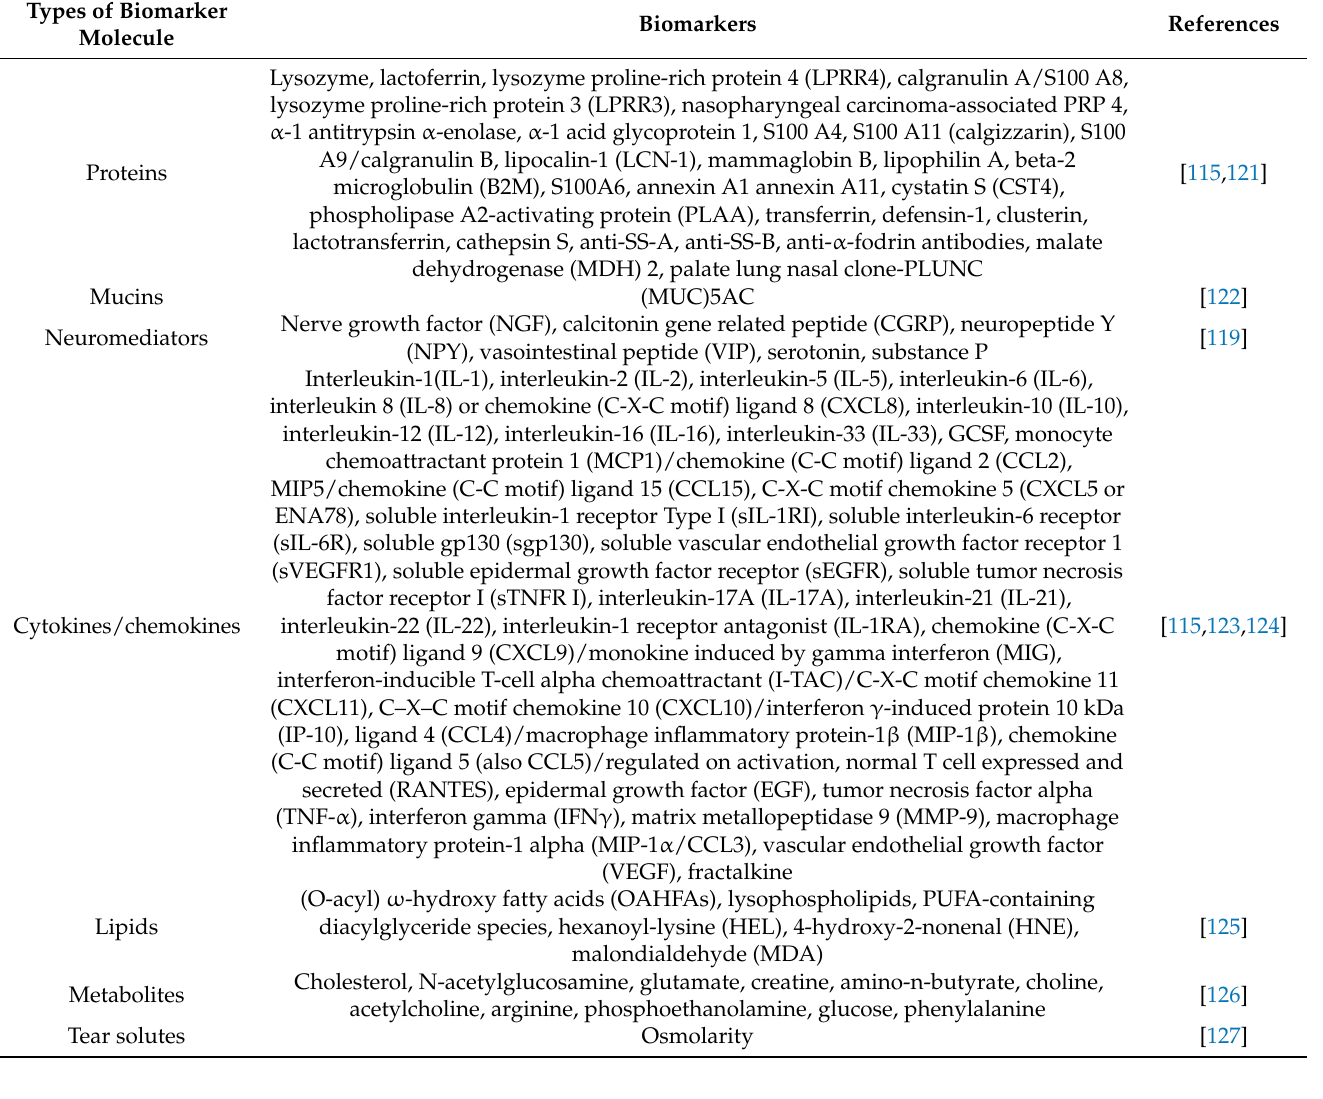
Table 6. DED biomarkers identified in tear